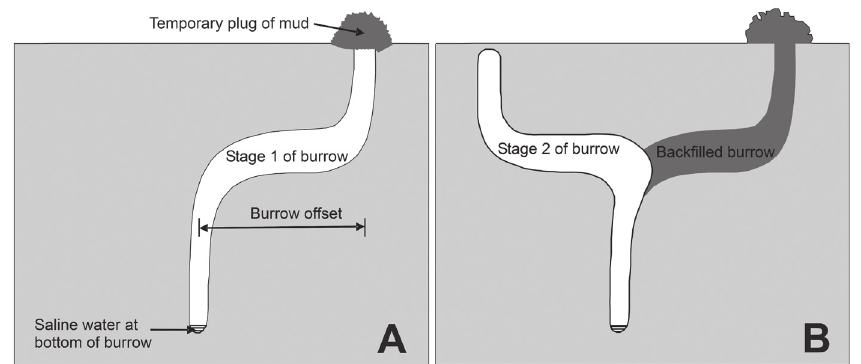
Fig. 3. Schematic burrow cross-section of salt lake dwelling Tetralycosa Roewer, 1960. A . Typical offset burrow of large immature and mature spiders. B . Burrow typical for the later part of summer, with original burrow